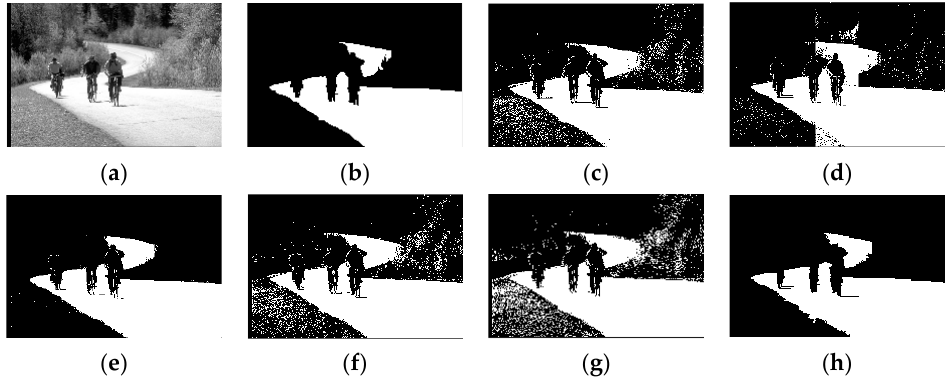
Figure 14. #253026 and its segmentations: ( a ) #253026, ( b ) ground-truth, ( c ) Otus, ( d ) MRCUT, ( e ) EITMIS, ( f ) NSWCC, ( g ) IT2FSWCC, ( h ) FSEFTISRI.